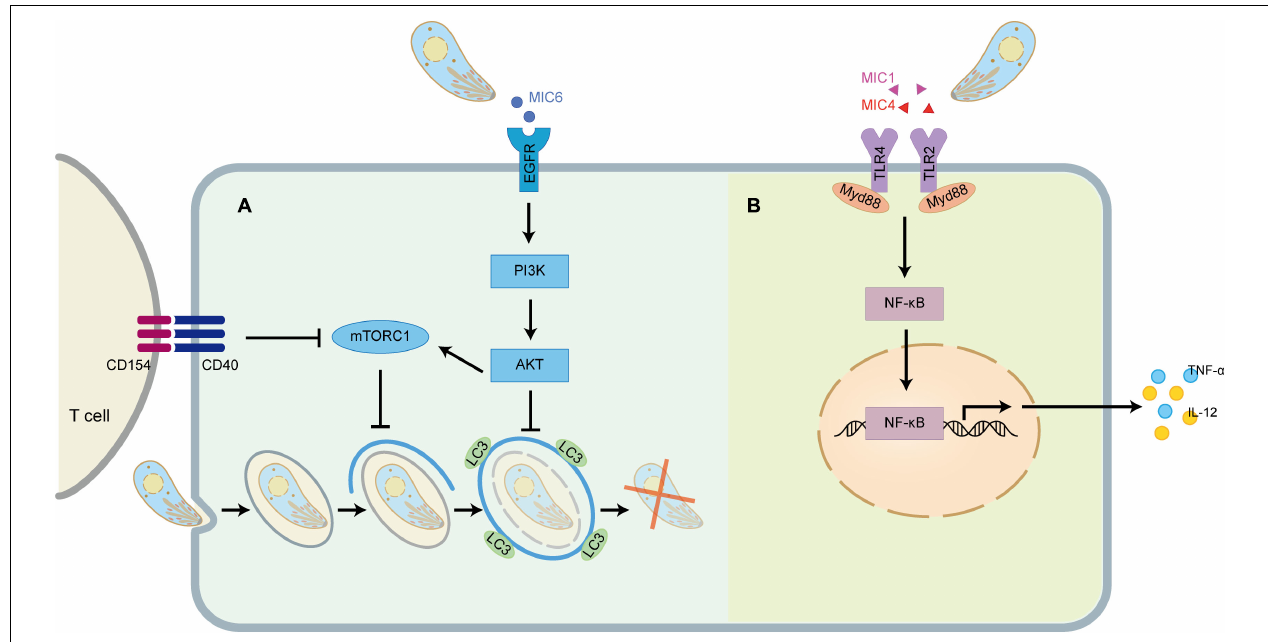
FIGURE 4 | TgMIC1/4/6 activates host immunity and immune evasion. (A) TgMIC6 secreted by T. gondii can bind to EGFR on the cell surface, activate the PI3K/AKT signaling pathway, prevent the initiation of phagophore and impair the ability of CD154 to induce LC3 accumulation around the parasite. (B) TgMIC1 and TgMIC4 can interact with TLR2 and TLR4, triggering the Myd88-dependent NF- κ B pathway to induce the production of IL-12 and TNF- α .